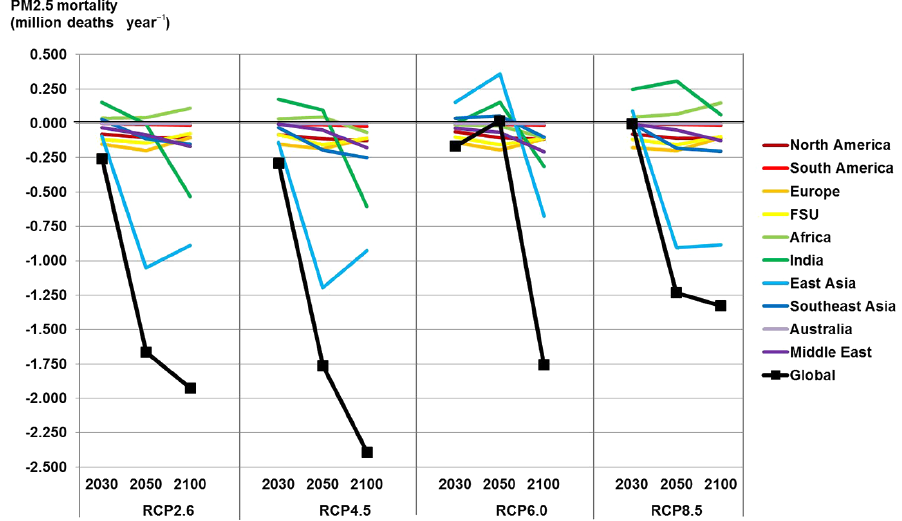
Figure 6. Future premature mortality (IHD + STROKE + COPD + LC) for PM 2 . 5 calculated as a sum of species, for all RCP scenarios in 2030, 2050 and 2100, showing the multi-model regional average (deaths per year) in 10 world regions (Fig. S1) and globally, for future air pollutant concentrations relative to 2000 concentrations.